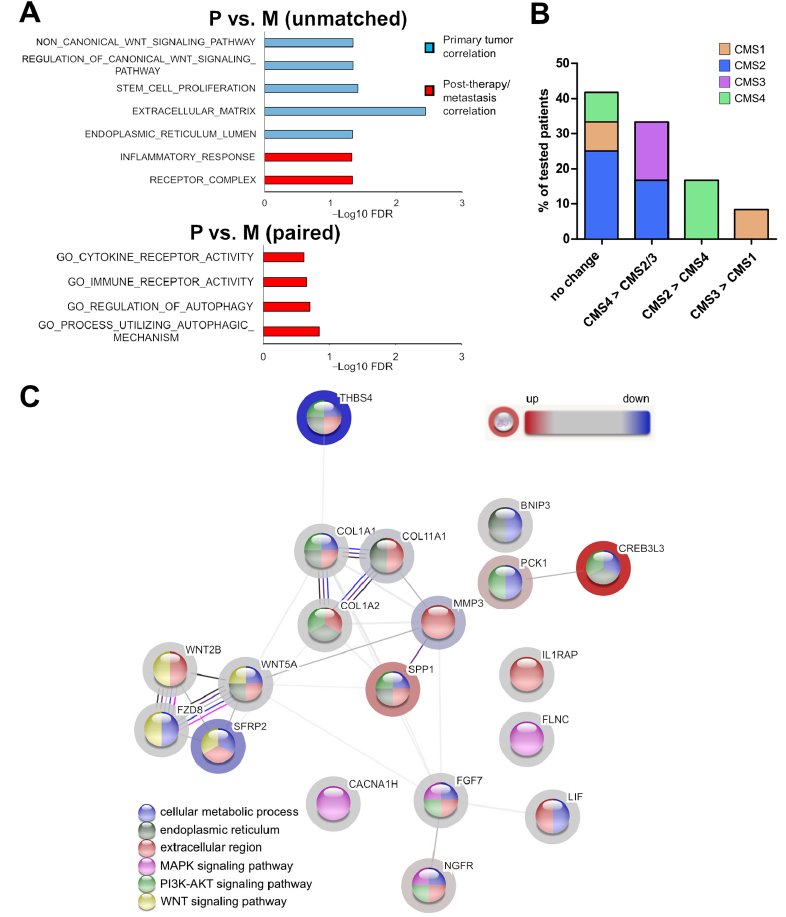
Figure 4. Association of the post-therapeutic liver metastasis CRC expression signature with cellular programs and pathways. ( A ) Gene ontology (GO) analyses of unmatched and paired samples utilizing all 443 gene expressions. ( B ) Changes in CMS classification from P to M in paired samples ( n = 12). ( C ) STRING analysis based on the fold change of the 19 identified signature genes in M. Known and predicted interactions as well as examples of significantly enriched cancer related pathways are